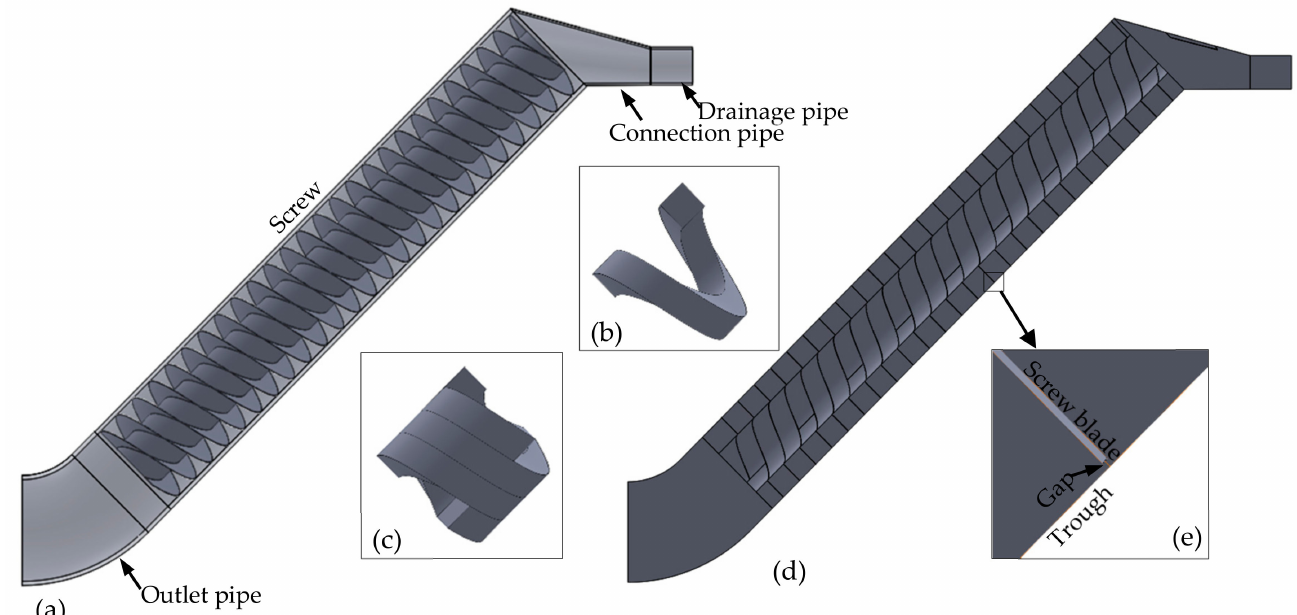
Figure 4. 3D fluid domain for AST model in SOLIDWORKS 2016. ( a ) cross-section of screw structure ( b ) fluid volume of single screw turn ( c ) fluid volume of three screw turns ( d ) cross-section of simulated fluid domain ( e ) zoomed view of the blade thickness and the gap between blade tip and